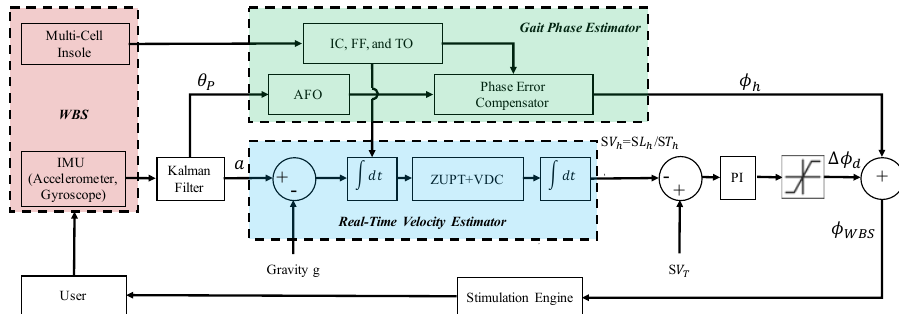
Figure 3. Flowchart of closed-loop vibrotactile control. θ p is the measured foot pitch angle, and a is the foot acceleration. SV h , SL h , and ST h are the real-time stride-to-stride estimates of stride velocity, stride length, and stride time, respectively. SV T represents the target walking speed. φ h and φ WBS are the user’s current gait phase and target phase, respectively. ∆ φ d is the target phase difference. IC, initial contact; FF, foot-flat; TO, toe-off; AFO, adaptive frequency